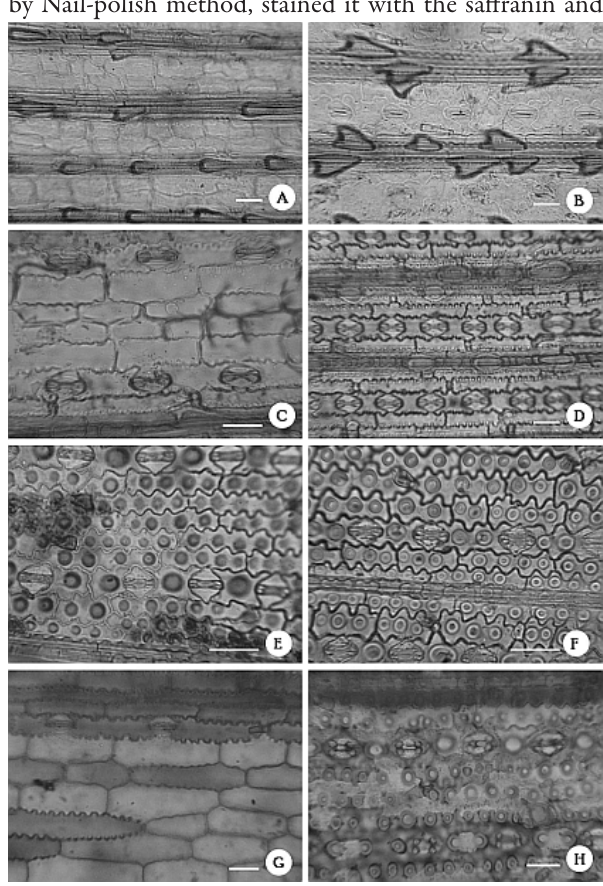
Fig. 1. Photomicrographs of leaf-blades: A, B: Apluda mutica ; C, Fig. 2. Photomicrographs of leaf-blades: A, B: